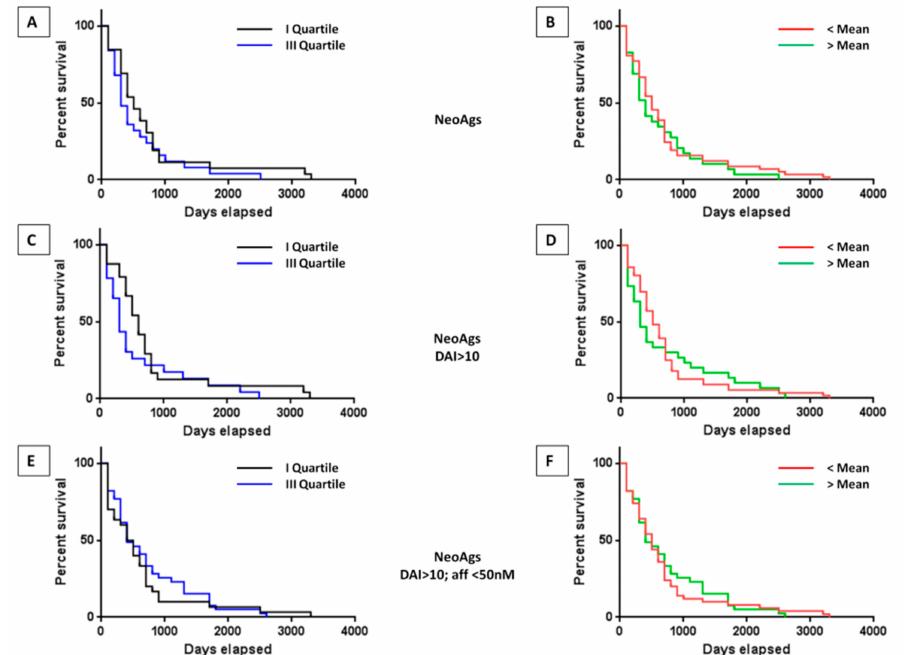
Figure 3. Survival of HCC patients with high and low number or quality of predicted neoantigens in the validation set, considering the value in the I and the III quartiles ( A , C , E ) as well as the value below and above the mean ( B , D , F ). Neoantigens: overall predicted neoantigens ( A , B ). Neoantigens DAI > 10: predicted neoantigens with a di ff erential agretopicity index (DAI) > 10 compared to the corresponding wild type epitope ( C , D ). Neoantigens DAI > 10; a ffi nity < 50 nM: predicted neoantigens as before, with a value of a ffi nity < 50 nM ( E , F ).